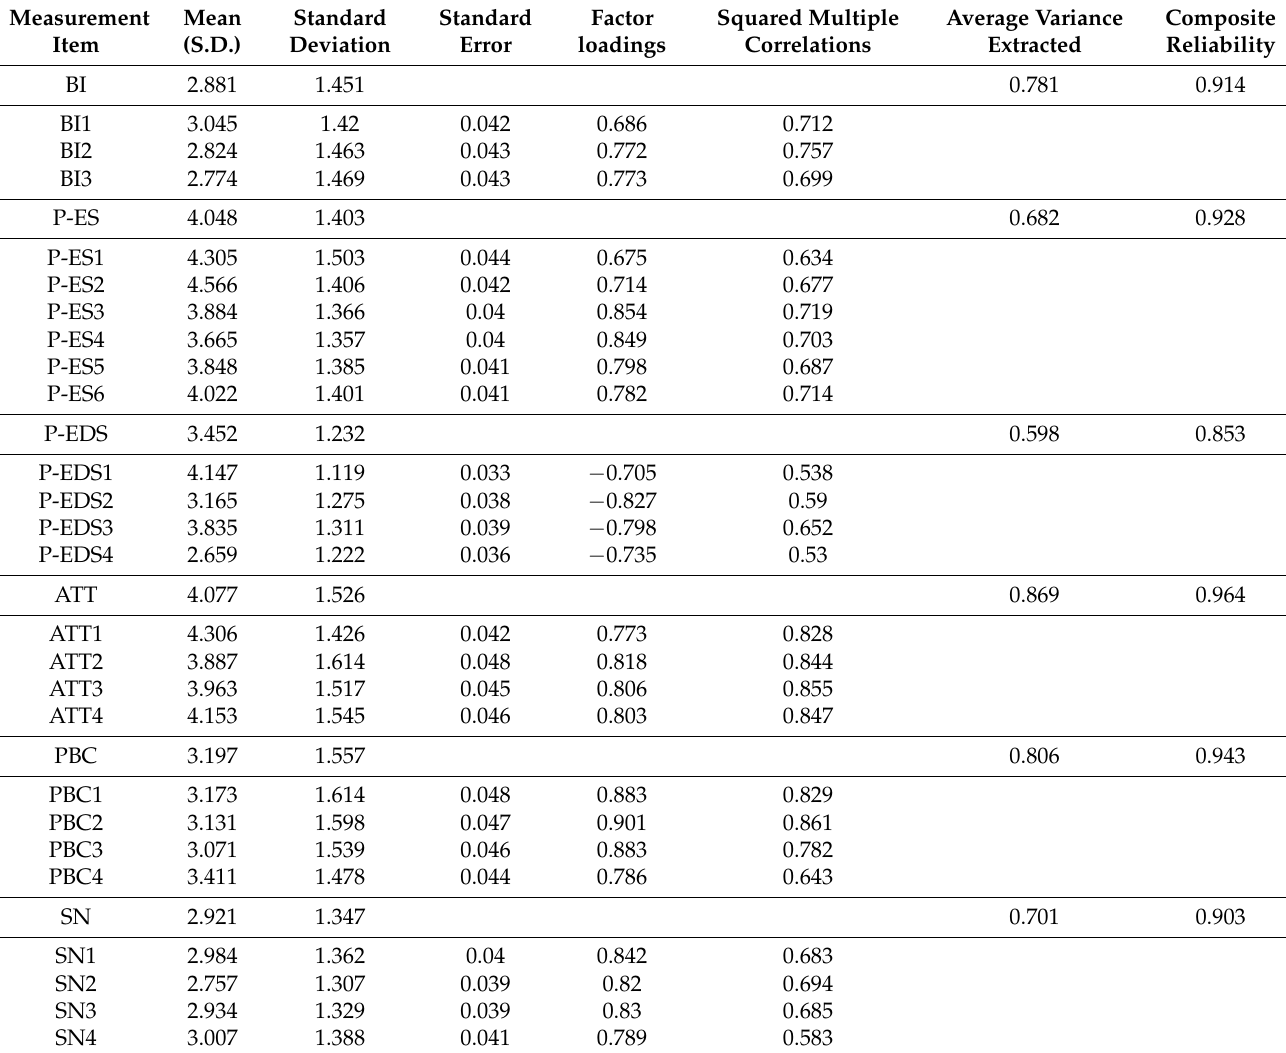
Table 4. Standardized estimates and psychometric properties of the parameters of the measurement